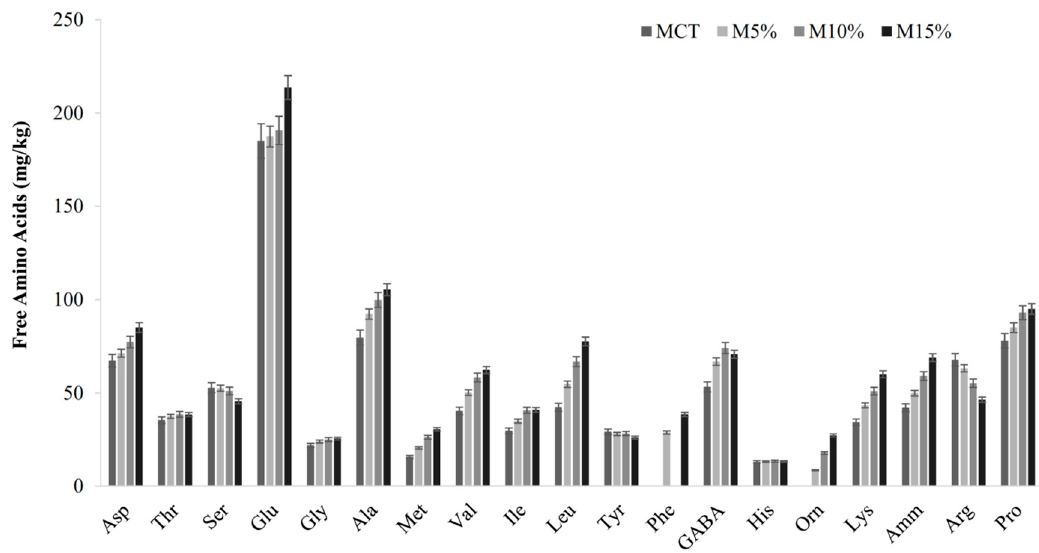
Figure 2. Concentration of free amino acids and amino acid derivatives (mg/kg) in teff muffins: M 5% , muffin containing 5% (wt/wt) type-I sourdough; M 10% , muffin containing 10% (wt/wt) type-I sourdough; M 15% , muffin containing 15% (wt/wt) type-I sourdough; M CT , muffin made without type-I sourdough. Data are the means of three independent batches analysis ± standard deviations (n = 3). Bars of standard deviations are also reported.